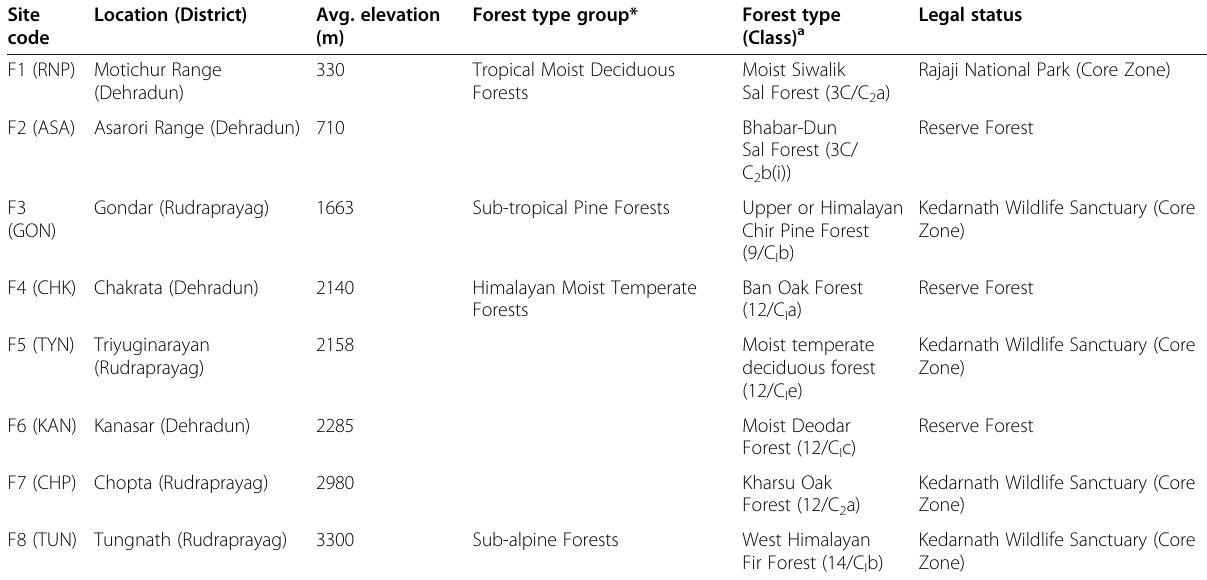
Table 1 Study areas with their general properties Site